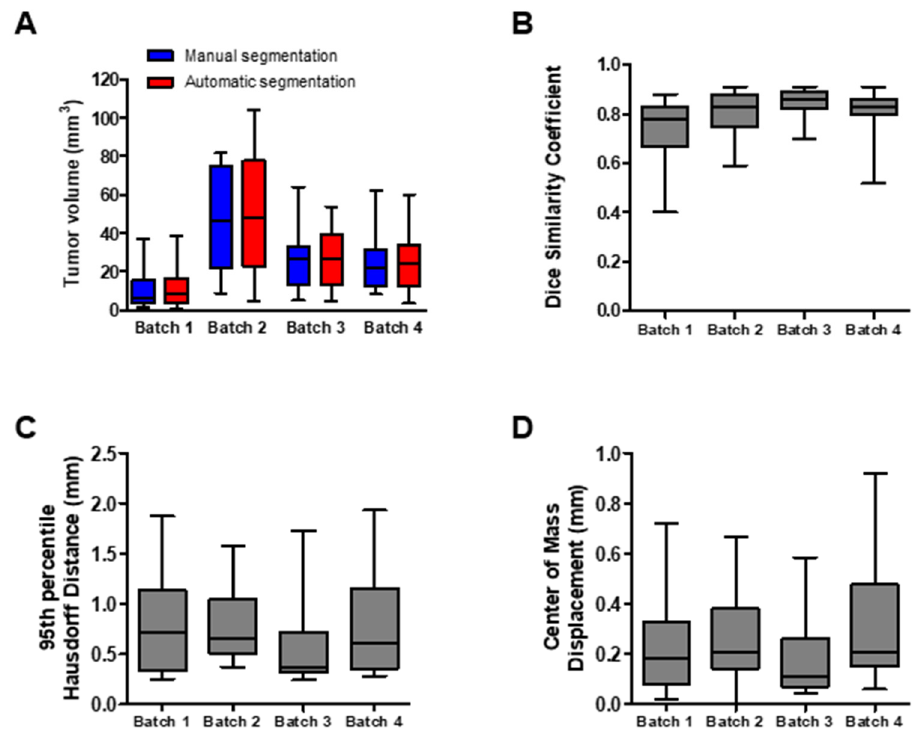
Figure 1. Quantitative performance metrics of deep learning algorithm. ( A ) Box plots showing the distribution of the tumor volumes in mm 3 per cross-validation batch ( n = 15), determined by manual and automatic segmentation. ( B – D ) Box plots of ( B ) the dice similarity coefficient, ( C ) 95th percentile Hausdorff Distance (in mm), and ( D ) the center of mass displacement (in mm), calculated for each of the batches.